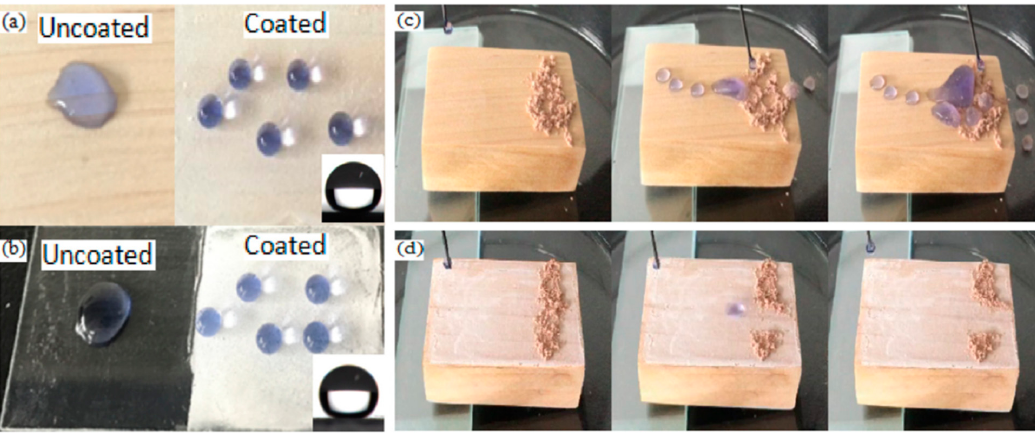
Figure 5. Demonstration of superhydrophobic coating from modified CNC with high contact angle on wood ( a ) and glass ( b ). Self-cleaning capability of uncoated ( c ) and coated ( d ) wood. Reproduced with permission from Huang et al . [53] . Elsevier copyright © 2018 .